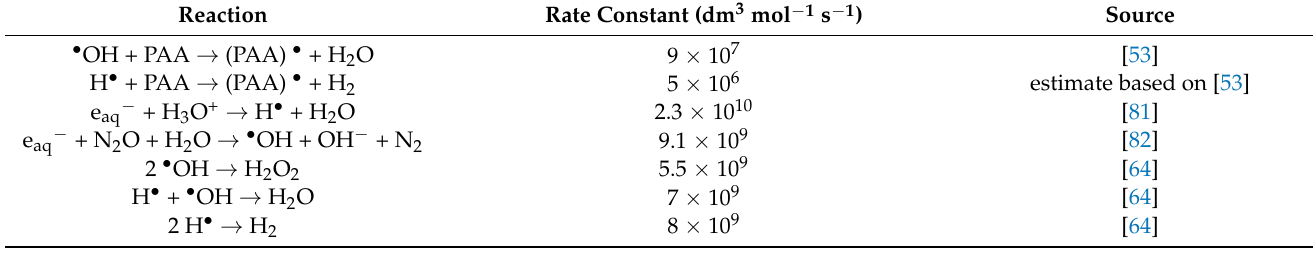
Figure 4. Pulse radiolysis of aqueous solution containing ( a ) 25 mmol dm − 3 OAA, ( b ) 150 mmol dm − 3 PA at various pH, dose per pulse around 60 Gy. Normalized absorbance at λ = 280 nm as a function of time after pulse. Solutions at pH 2 saturated with Ar, at pH 5 and 9 saturated with N 2 O.